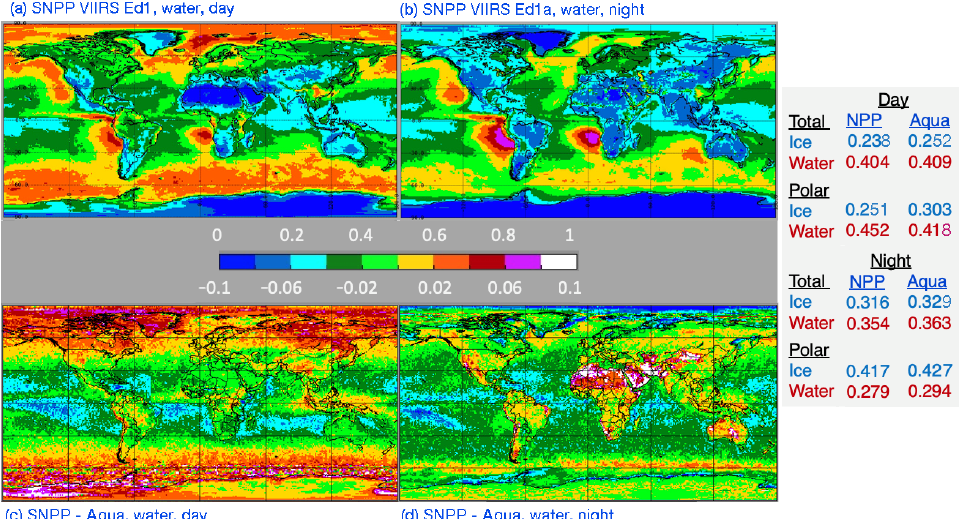
Figure 5. Mean 2013 liquid cloud amounts from CV1S for ( a ) day and ( b ) night and the differences between CV1S and CM4A for ( c ) day and ( d ) night. The table lists the average liquid and ice cloud amounts for the globe and polar regions